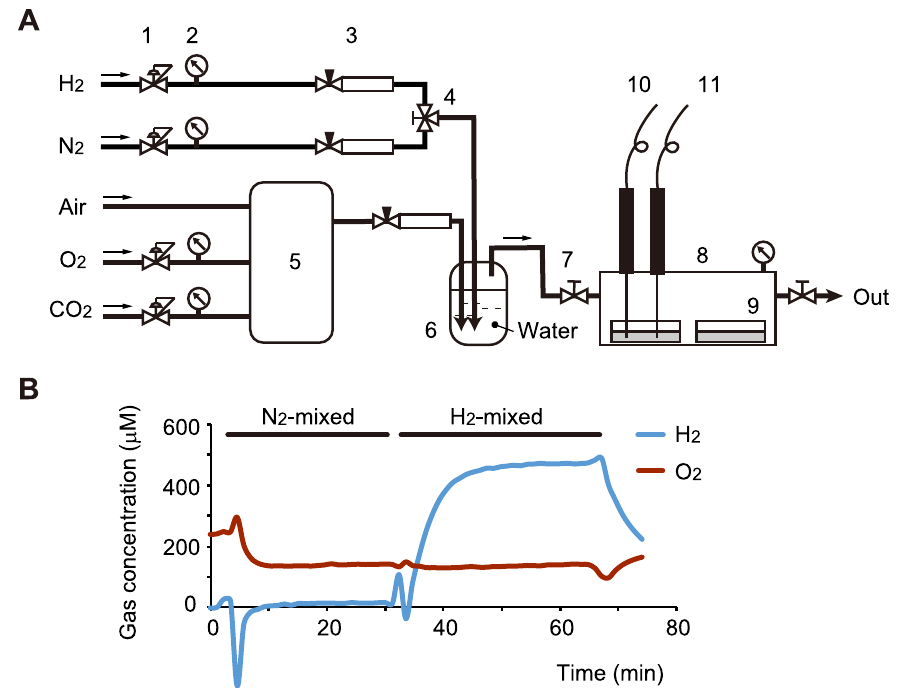
Fig 1. Cell culture systemunder an atmosphere containing H 2 gas. (A) Schematicrepresentation of the culture system. 1. Pressure-reducing regulator.2. Pressure gauge. 3. Flowmeter with flow control valve. 4. Three-way plug valve. 5. Multi-gas controller. 6. Bubbler bottle. 7. Gate valve. 8: Acrylamide box. 9. Culture dish. 10.